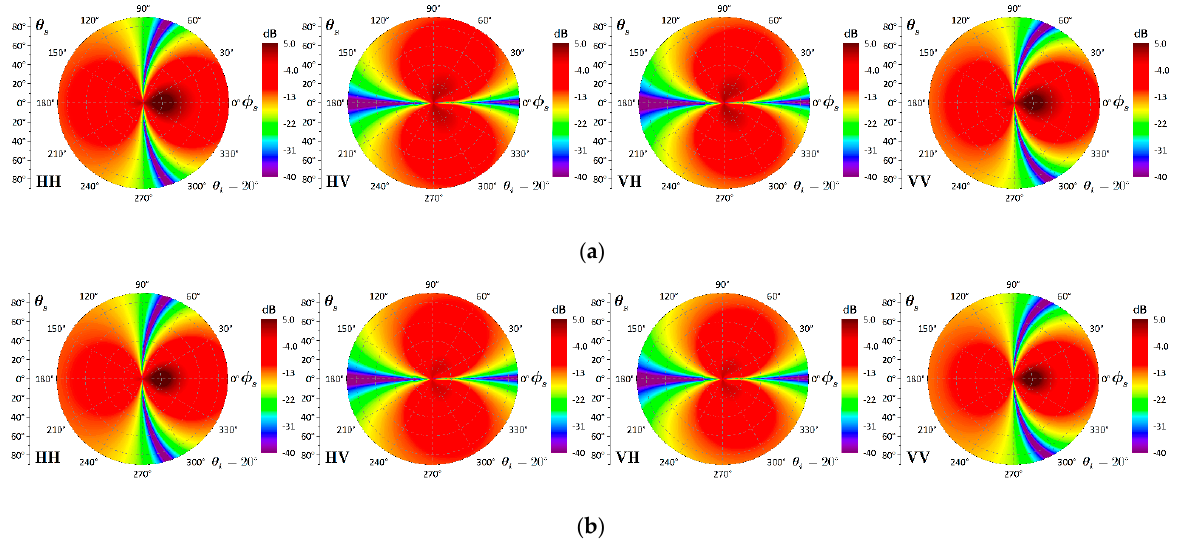
Figure 9. Bistatic scattering from the Gaussian and exponential HPDs with the exponential PSD: kl = 8, k σ = 1.0, ε r = 15 − j 1.5, θ i = 20. ( a ) Gaussian HPD and exponential PSD (Gau HPD and Exp PSD), ( b ) exponential HPD and exponential PSD (Exp HPD and Exp PSD).